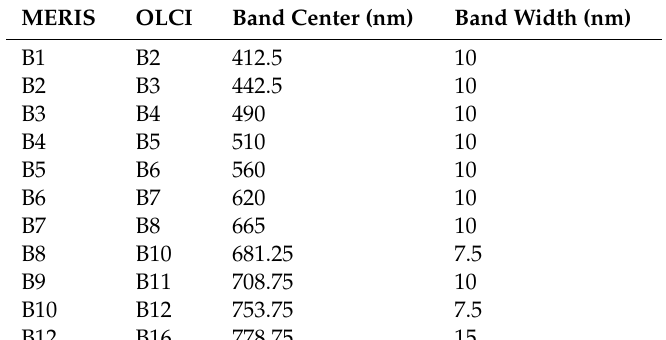
Table 3. Band specifications of the MERIS and OLCI used in this study.